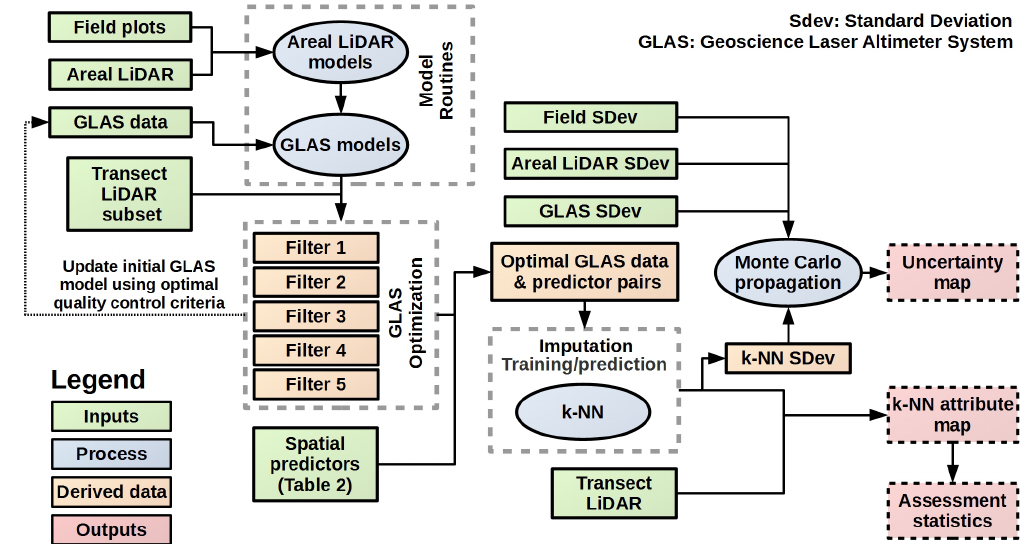
Figure 2. General workflow of the developed methods framework. Note, merged data refers to each set of filtered data (response and predictor variables) being submitted to the k-NN